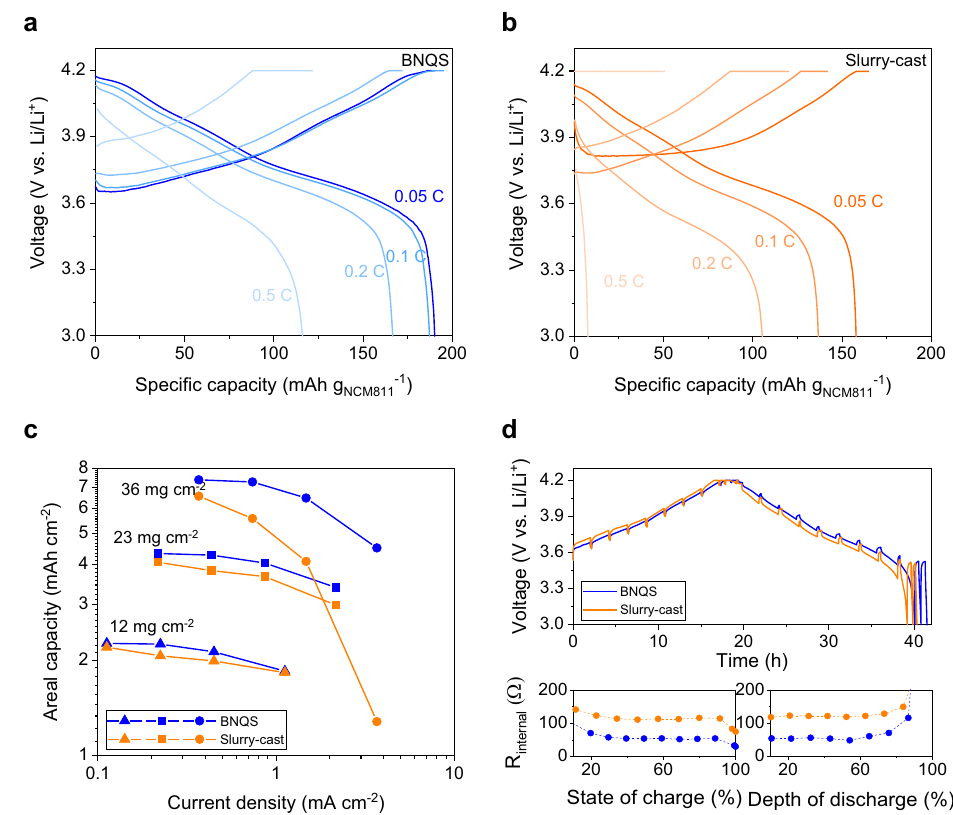
Fig. 3 Electrochemical performance of the BNQS cathode (versus slurry-cast cathode). Charge/discharge pro fi les of a slurry-cast and b BNQS cathodes (areal-mass-loading of 36 mg cm − 2 ) under varied charge/discharge current rates (0.05 C/0.05 C ( = 0.35 mA cm − 2 ) – 0.5 C/0.5 C ( = 3.5 mA cm − 2 )). c Areal capacity of the cathodes with different areal-mass-loading (varying from 12 to 36 mg cm − 2 ) as a function of current density. d (top) GITT pro fi les upon repeated current stimuli at charge/discharge current density of 0.05 C/0.05 C ( = 0.35 mA cm − 2 ) and (bottom) internal cell resistance (R internal ) as a function of SOC and DOD.